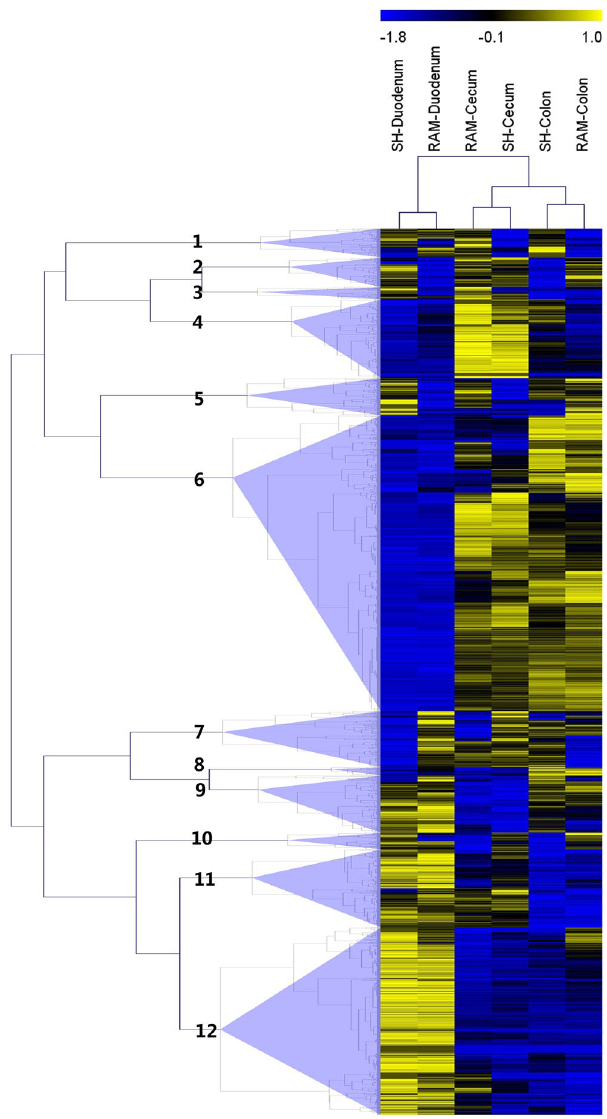
Figure 1. Clustered heat map showing the expression patterns of transcripts differentially expressed between the duodenum and the large